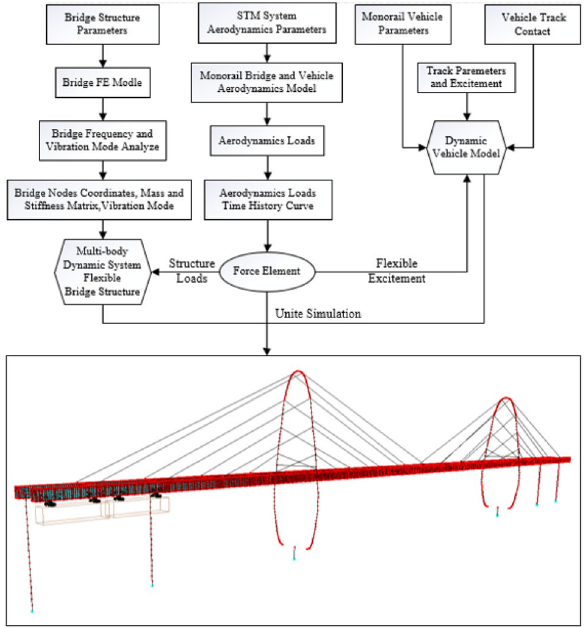
Fig. 6 Multi-body dynamic simulation process